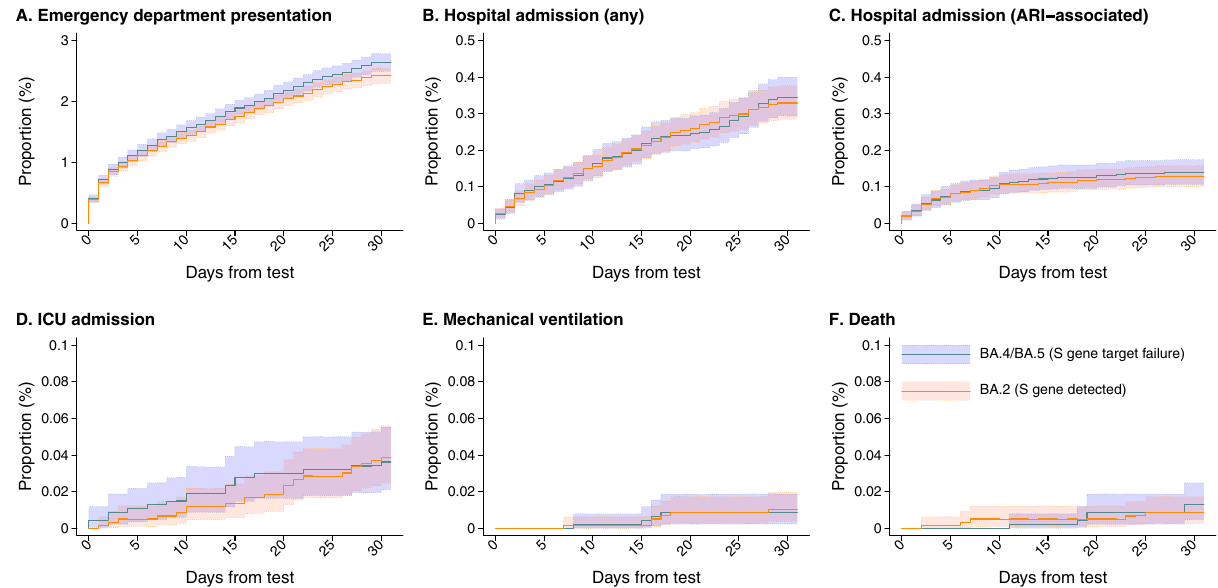
Fig. 2 | Clinical outcomes among cases with BA.2 and BA.4/BA.5 lineage SARS- CoV-2infection,tested29April,2022to29July,2022. Plotsillustratecumulative 30-day risk of severe clinical outcomes among cases fi rst ascertainedin outpatient settings, strati fi ed by SGTF status for infecting subvariant (BA.4/BA.5 [SGTF]: orange; BA.2 [No SGTF]: blue), for endpoints of any emergency department (ED) presentation ( A ); any inpatient admission ( B ); inpatient admission associated with an acute respiratory infection (ARI) diagnosis ( C ); intensive care unit (ICU) admis- sion ( D ); mechanical ventilation ( E ), and death ( F ). Shaded areas denote 95%